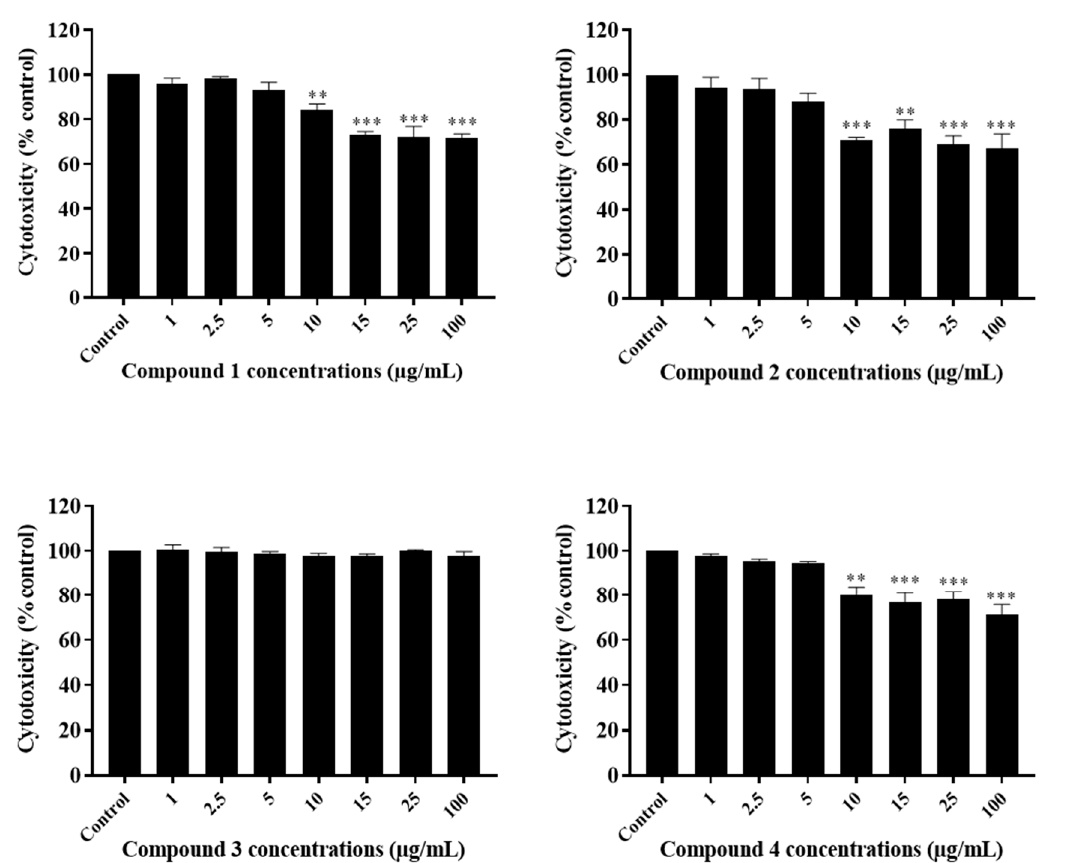
Figure 7. Cytotoxic effect of Sal- A derivatives on HCT116 cells. Cells were treated with 1% DMSO (control) or the indicated concentrations of the compounds for six hours. The cytotoxic activity was determined in triplicate wells by the lactate dehydrogenase assay. Results are expressed as percentage of control and represent the average of three independent experiments ± SEM. Statistical significance is reported by one-way ANOVA post hoc Tukey test indicating differences between treatment concentrations and control (**, p < 0.01; ***, p <